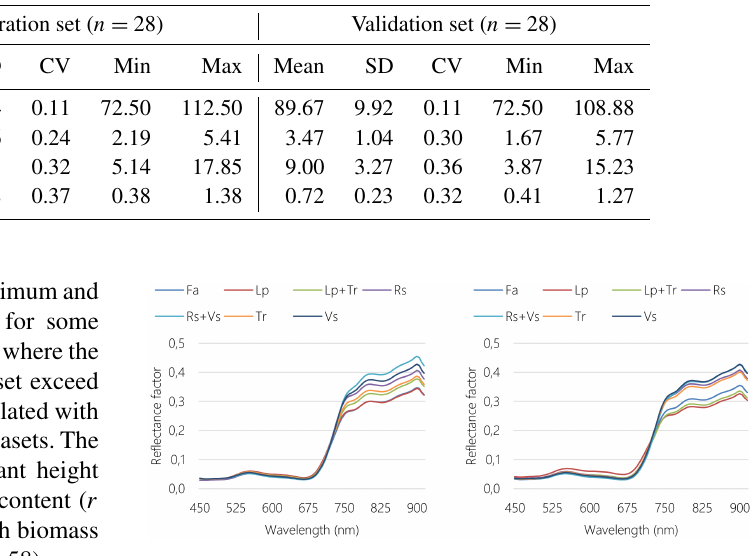
Figure 4. Average reflectance spectrum of oat grown in the dif- ferent experimental plots and their associated treatments for the calibration ( n = 28, left) and validation set ( n = 28, right). Plant legacy treatments are Fa: fallow; Lp: Lolium perenne ; Rs: Raphanus sativus ; Tr: Trifolium repens ; Vs: Vicia sativa ).